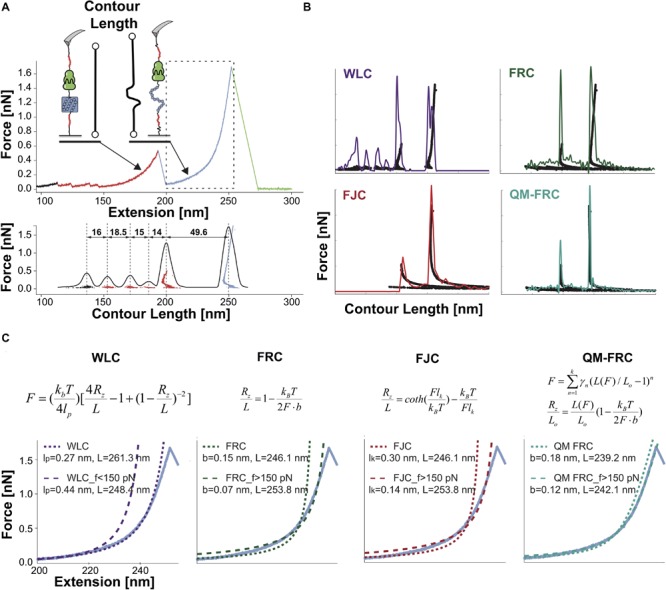
Overview of SMFS data processing by contour length transformation and molecular fingerprinting. (A) Top: a typical force vs. extension trace for stretching a multi-domain polyprotein assembled through a mechanically stable receptor-ligand complex. Red shows unfolding and stretching of two low-force marker domains [ddFLN4 (Schwaiger et al., 2004)], followed by unfolding and stretching of a mid-stability marker domain [CBM (Stahl et al., 2012)], followed by rupture of the mechano-stable receptor-ligand complex [SdrG:Fgβ (Milles et al., 2018)]. Bottom: Assembly of a contour length histogram following transformation into contour length space using an elasticity model of choice. Distances between peaks of the contour length histogram are used to make domain assignments to unfolding events in the data trace. (B) Four polymer elasticity models were used to transform the data from panel A. WLC, worm-like chain; FRC, freely-rotating chain; FJC, freely-jointed chain; QM-FRC, quantum mechanical freely rotating chain. For data traces that span a range of forces from <0.1 nN to >1 nN, the QM-FRC model is preferred. (C) Transformation equations of the various non-linear elasticity models and examples of model performance on test data showing stretching of unfolded CBM and rupture of the SdrG:Fgβ complex. The two curves in each plot show two separate fitting regimes below and above 150 pN.